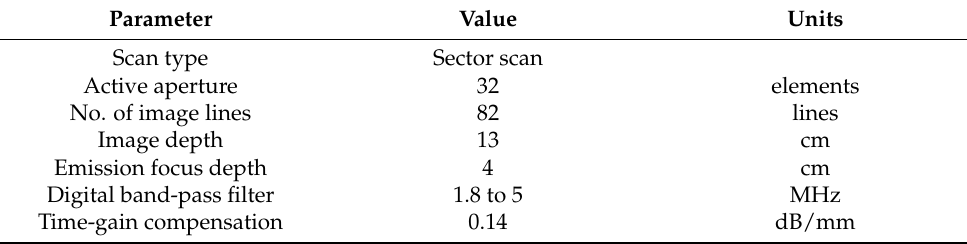
Table 1. Ultrasound image